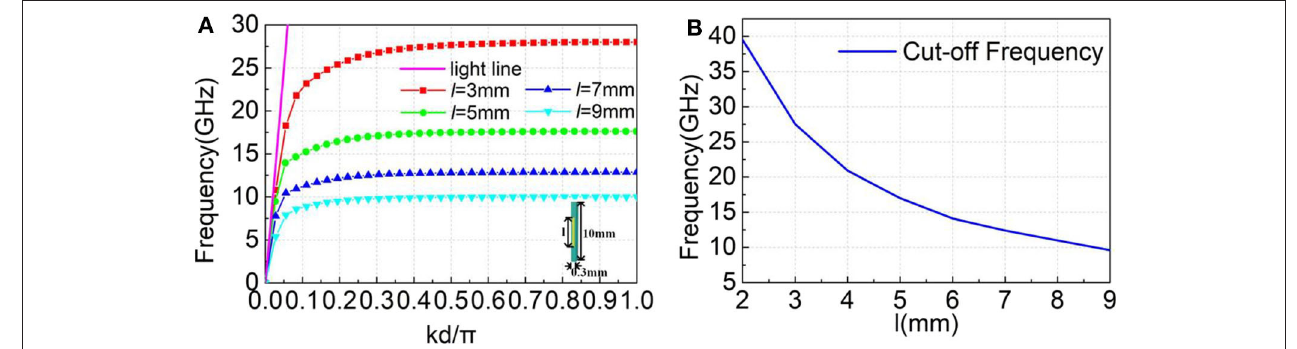
FIGURE 6 | Dispersion diagram and cut-off frequency. (A) The dispersion diagram of the equivalent electric dipole of a short metallic strip patterned on a dielectric substrate and (B) the fitting curve between the unit length and frequency.